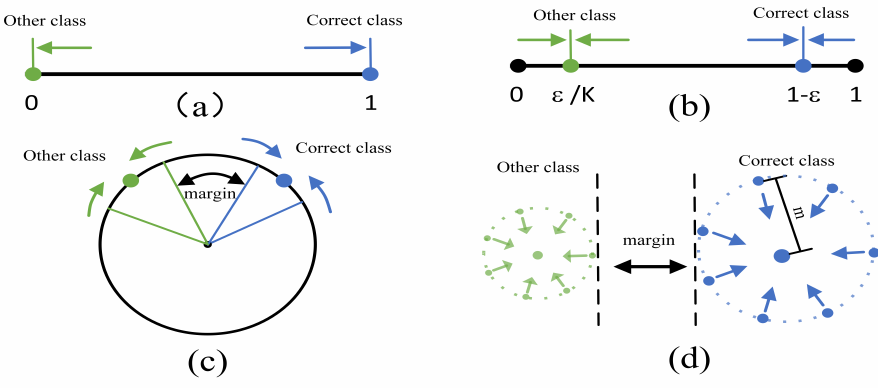
Figure 2. Intuitive explanation of label regression. ( a ) is the softmax cross entropy case; ( b ) is the label smooth case; ( c ) is the ArcFace case; ( d ) is the inference softmax cross entropy